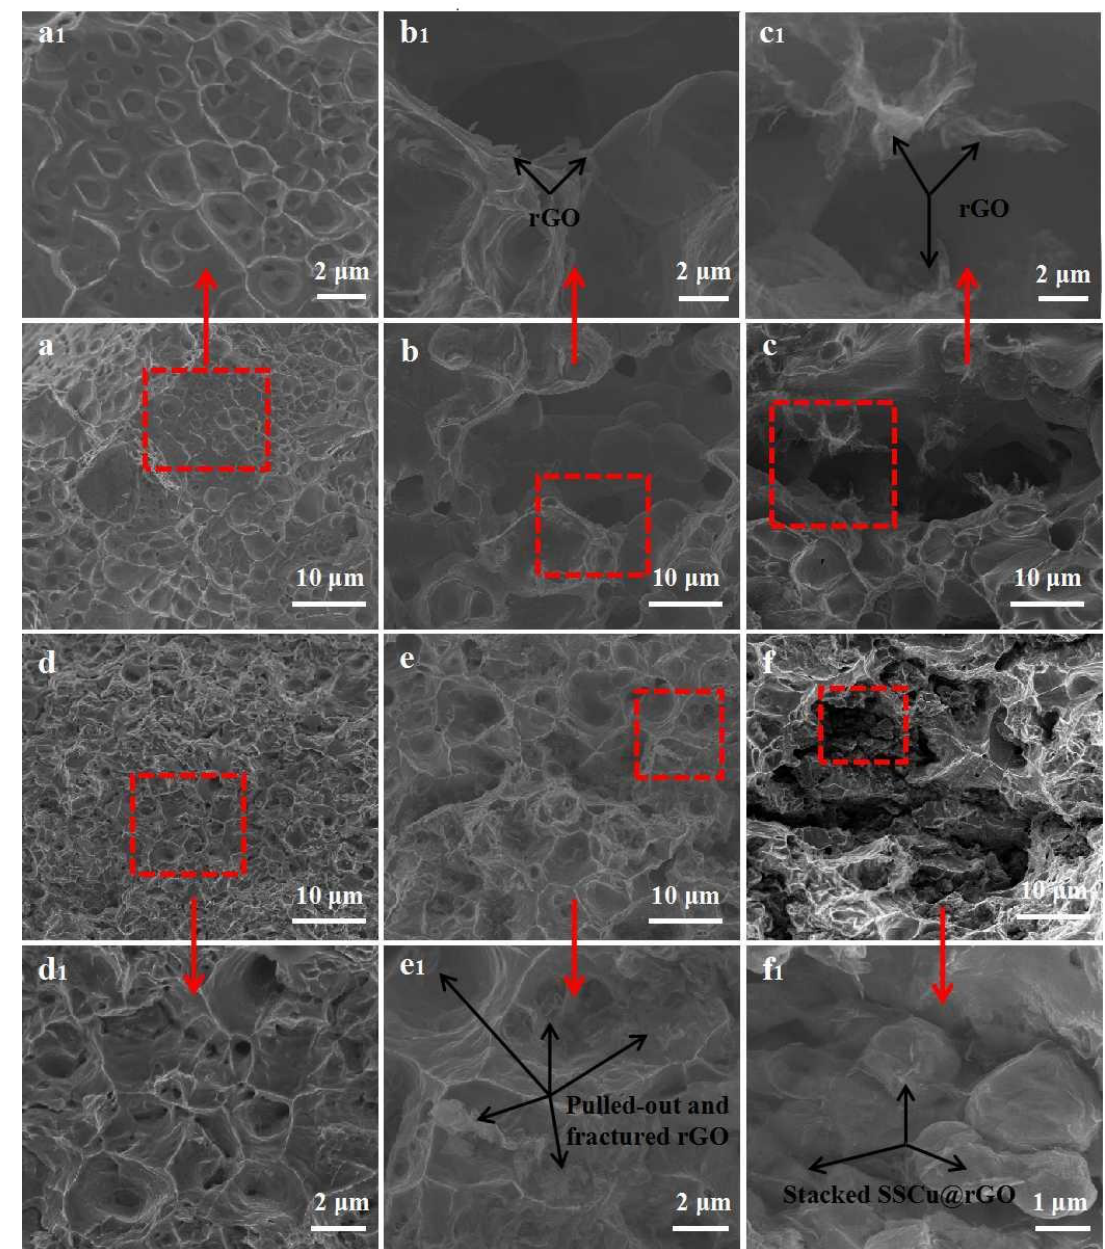
Figure 5. SEM images of the tensile fracture surface of the composites: ( a ) Cu, ( b ) 0.3 wt % rGO/Cu, ( c ) 0.5 wt % rGO/Cu, ( d ) SSCu/Cu, ( e ) SSCu@0.3 wt % rGO/Cu, and ( f ) SSCu@0.5 wt % rGO/Cu. ( a 1 – f 1) are the magnified views of the areas surrounded by the red boxes in ( a – f ), respectively.